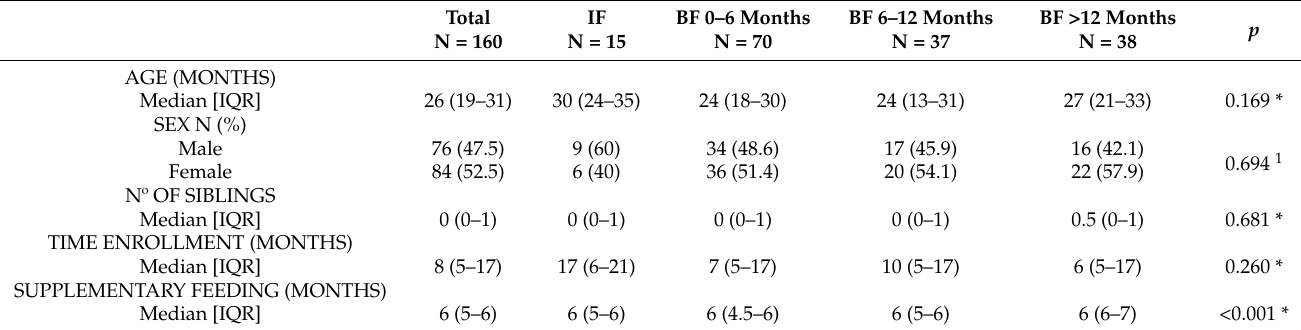
Table 1. Characteristics of the children participating in the